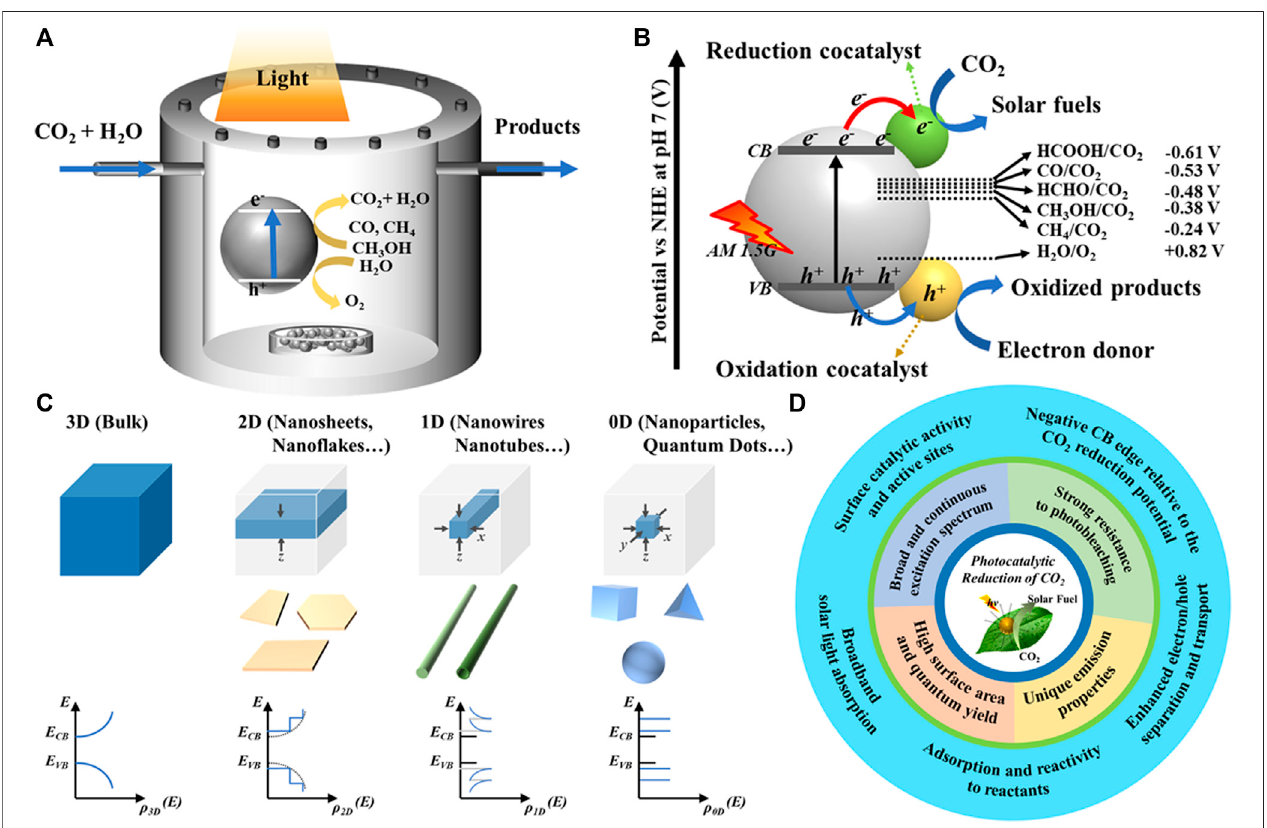
FIGURE 1 | Schematic illustration of the (A) photocatalytic CO 2 conversion method, (B) CO 2 conversion by semiconducting photocatalyst, (C) density of states modi fi cation under different degrees of quantum con fi nement, and (D) the advantages of the QDs for the photocatalytic reduction of CO 2 .